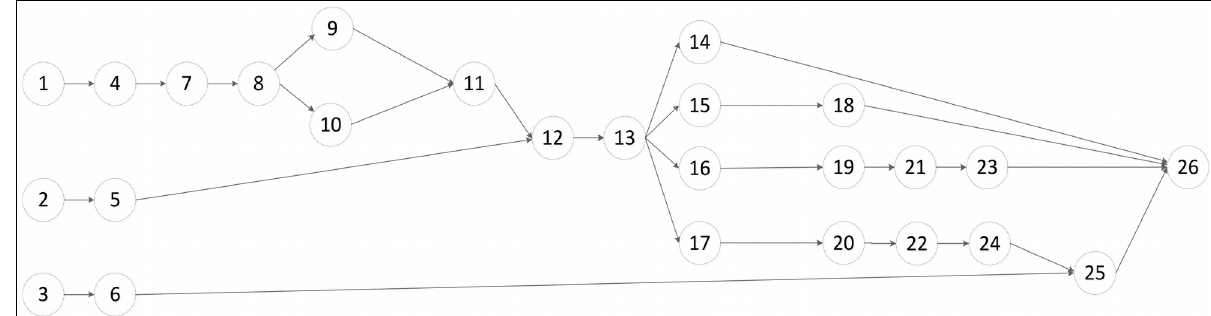
Figure 5. AON for the PHB-TR 252 Component Assembly Process